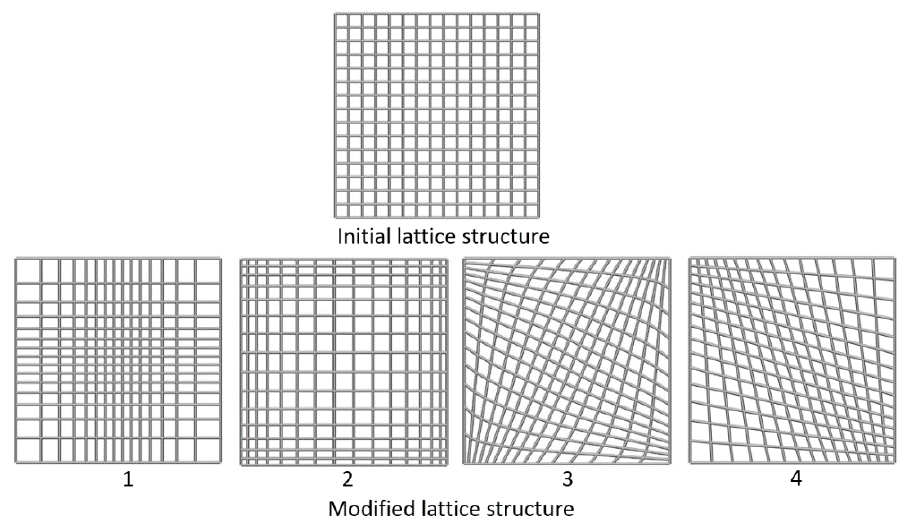
Figure 4. Modification of lattice structures by moving mesh nodes.